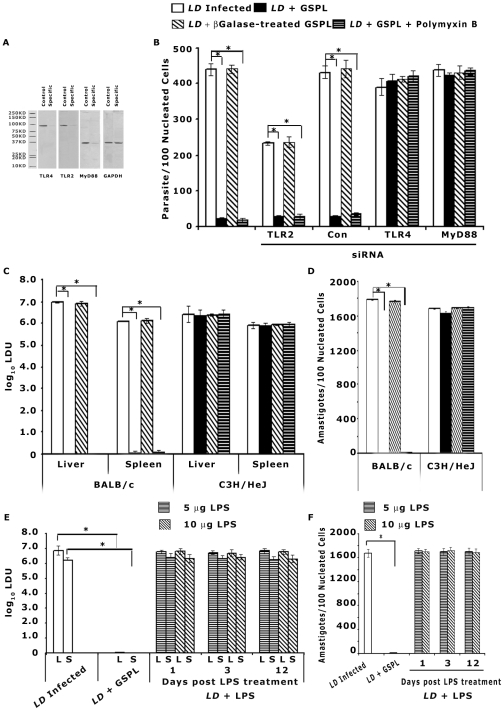
TLR4 and MyD88 are required for GSPL induced anti-leishmanial response.(A) Splenic adherent cells were transfected with siRNAs specific to TLR2, 4 or MyD88 (specific). A control group was transfected with control siRNA (control). Twenty-four hours after transfection, cells were recovered and their TLR2, 4 and MyD88 levels assessed in Western blots. GAPDH in total proteins was used as loading controls. Blots are representative of three separate experiments. (B) Splenic adherent cells transfected with TLR2, TLR4, MyD88 or control siRNA (con), were infected with LD (APC/parasite 1∶20) for 12 h. Non-ingested promastigotes were removed by washing, and adherent cells were cultured for another 36 h. Infected APCs were then treated with GSPL (100 µg/mL) for 24 h. Intracellular parasite number was determined by Giemsa staining. Each experiment was conducted in triplicate and repeated at least three times each and one set of representative data is shown. Error bars represent mean ± SD. * p<0.0001; paired two-tailed Student's t-test. (C,D) Antileishmanial effect of GSPL on parasite growth in TLR4 deficient C3H/HeJ mice. Sixty days LD infected C3H/HeJ mice were given two subcutaneous injections of GSPL (100 µg each) at 15 days apart. The parasite burdens in liver (C), spleen (C), and bone marrow (D) of individual animals were then determined at 15 days after the last treatment. The results are representative of three independent experiments and data shown are means ± SD; n=5. *p<0.0001 versus corresponding infected control; paired two-tailed Student's t-test. (E,F) In vivo parasite load in liver, spleen and bone marrow of LD infected BALB/c mice treated with LPS. Sixty days LD infected BALB/c mice were given three intraperitoneal injections of LPS on alternate days (5 µg/injection or 10 µg/injection). The parasite burdens in liver (E), spleen (E), and bone marrow (F) of individual animals were then determined at days 1,3 and 12 after the last treatment. The results are representative of three independent experiments and data shown are means ± SD; n=3. *p<0.0001 versus corresponding infected control; paired two-tailed Student's t-test.